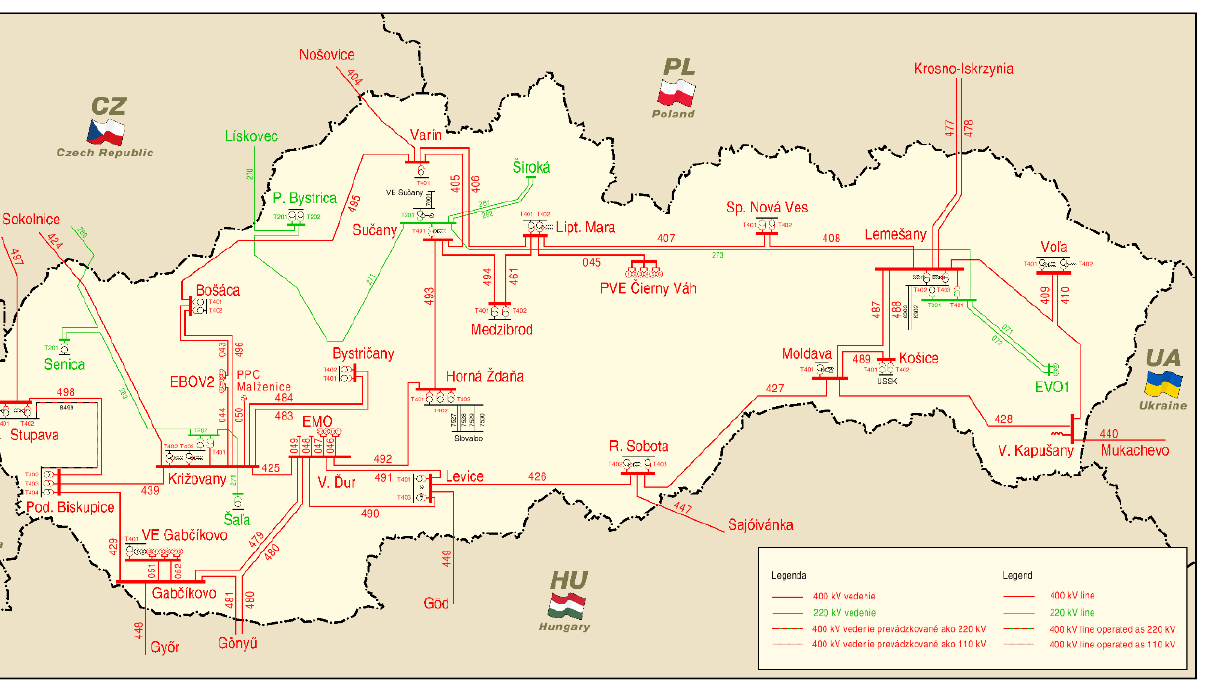
Figure 2. Transmission system of the Slovak Republic [22].